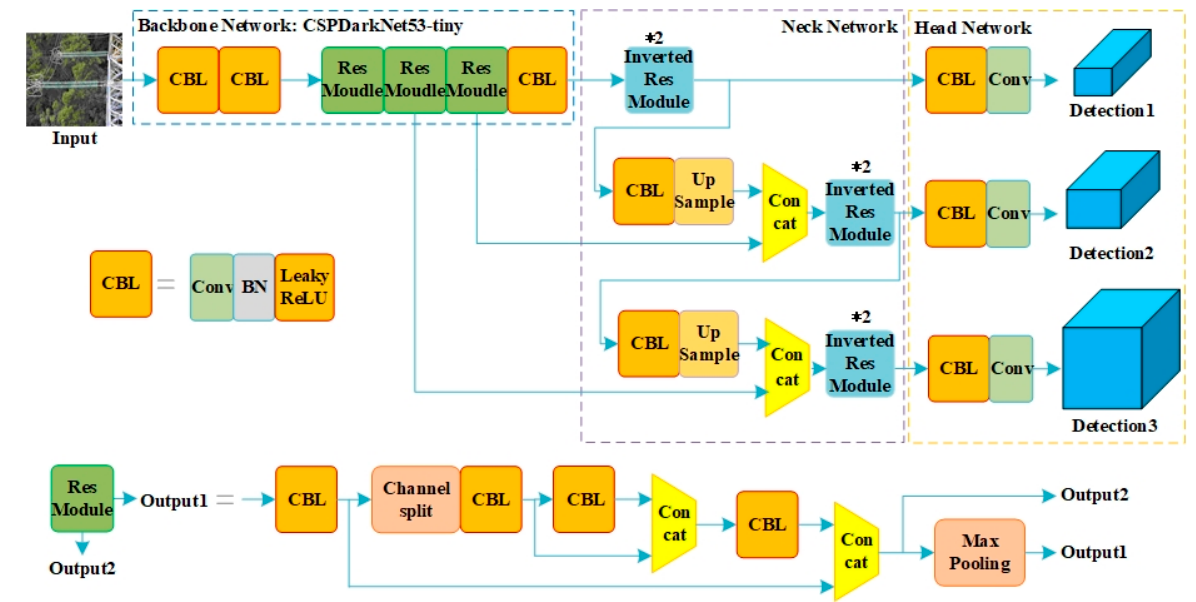
Machines 2023 , 11 , x FOR PEER REVIEW Figure 4. Overall network structure of improved YOLOv4-tiny. Figure 4. Overall network structure of improved YOLOv4-tiny.